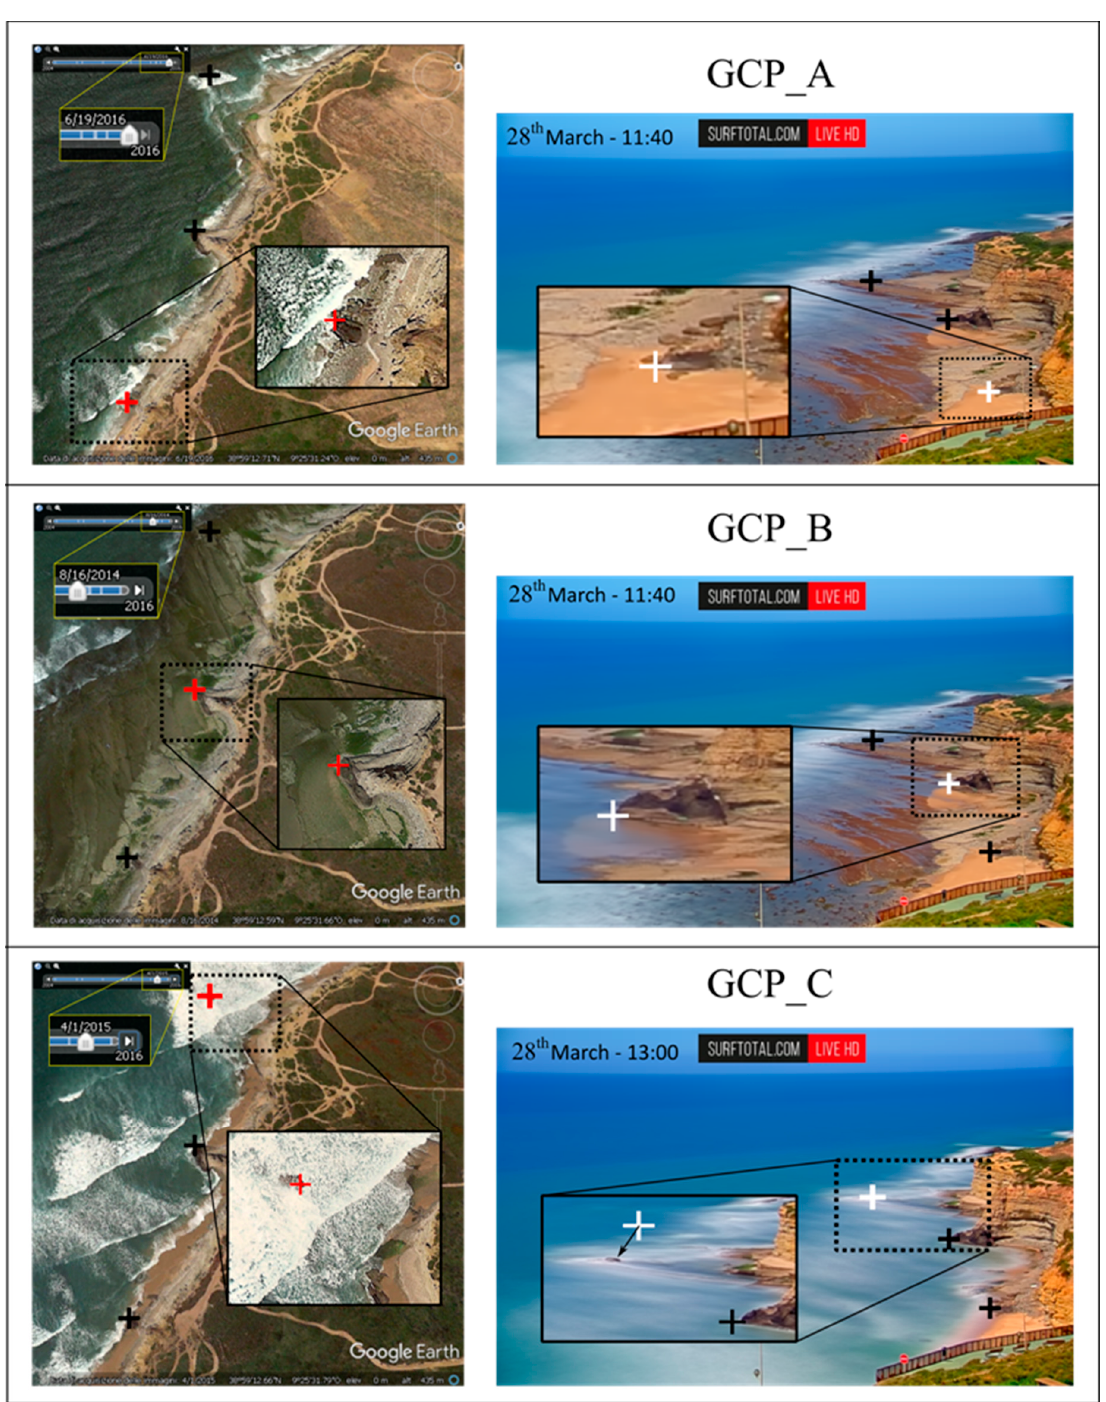
Figure 4. Ground control points (GCPs) identified on Google Earth maps ( left column ) and related points identified on Timex image ( right column ). Insets represent the magnified areas, which are shown by the dashed black rectangles. Red and white crosses are the GCPs indicated in the figure title, from the Google Earth map and surfcam image, respectively. Black crosses recall GCPs locations.